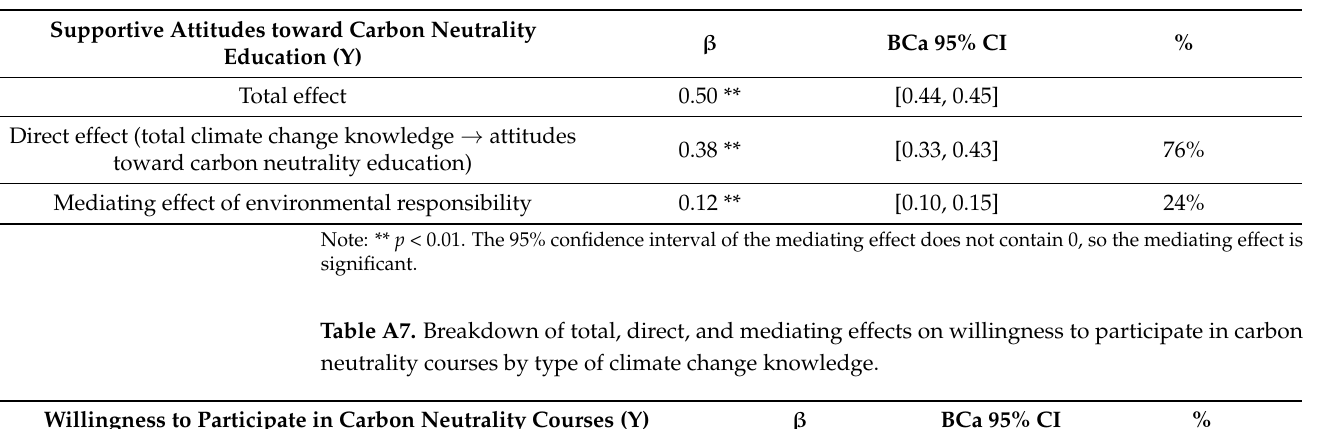
Table A6. Breakdown of total, direct, and mediating effects on supportive attitudes toward carbon neutrality education by type of climate change knowledge.